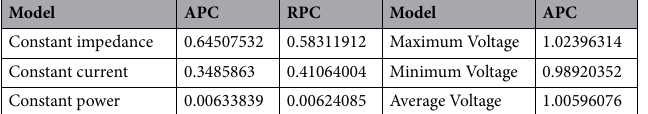
Table 1. Policentro ZIP static load model coefficients and voltage bus values.